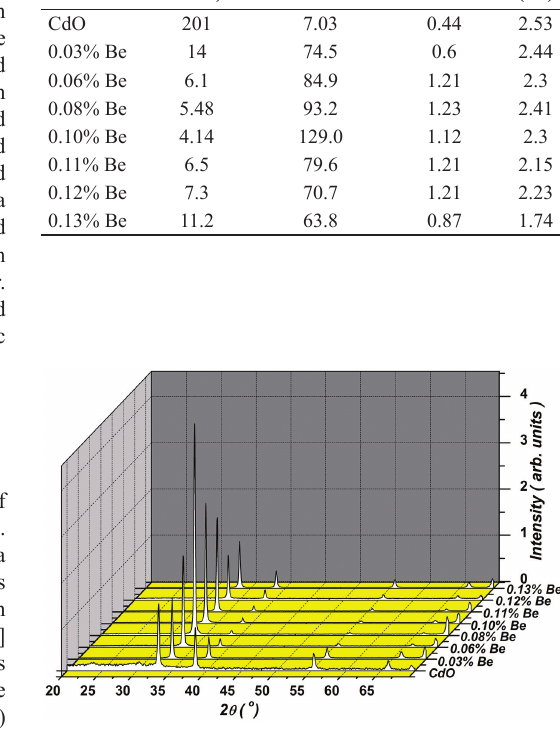
Figure 1. X-ray diffraction patterns for pure and Be-doped CdO films deposited on glass substrates. The radiation used was Cu K